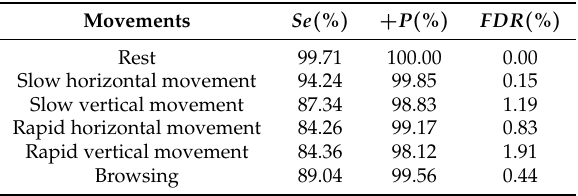
Table 7. Results of sensitivity, positive predictivity, and failed detection rate of all experiment stages of all subjects by the weighted average